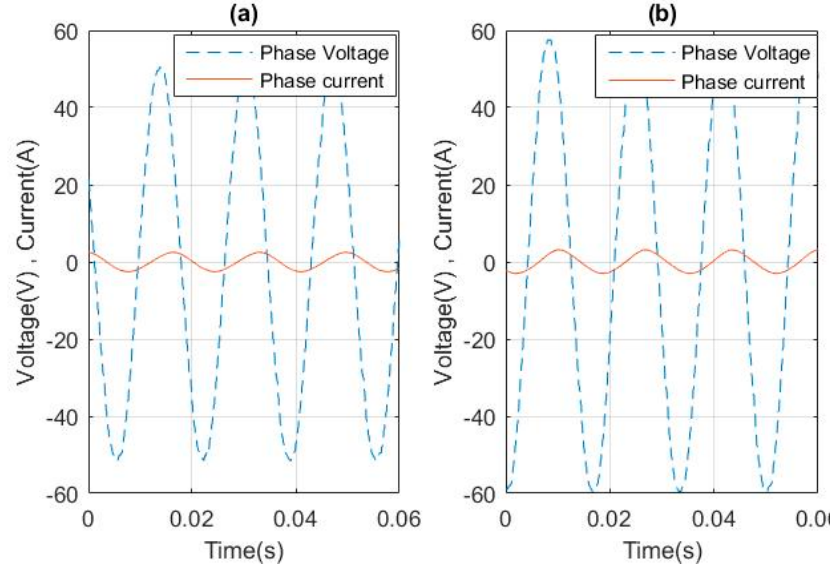
Figure 16. Current and voltage wave form with phase a aligned with ( a ) d-axis ( b ) q-axis.